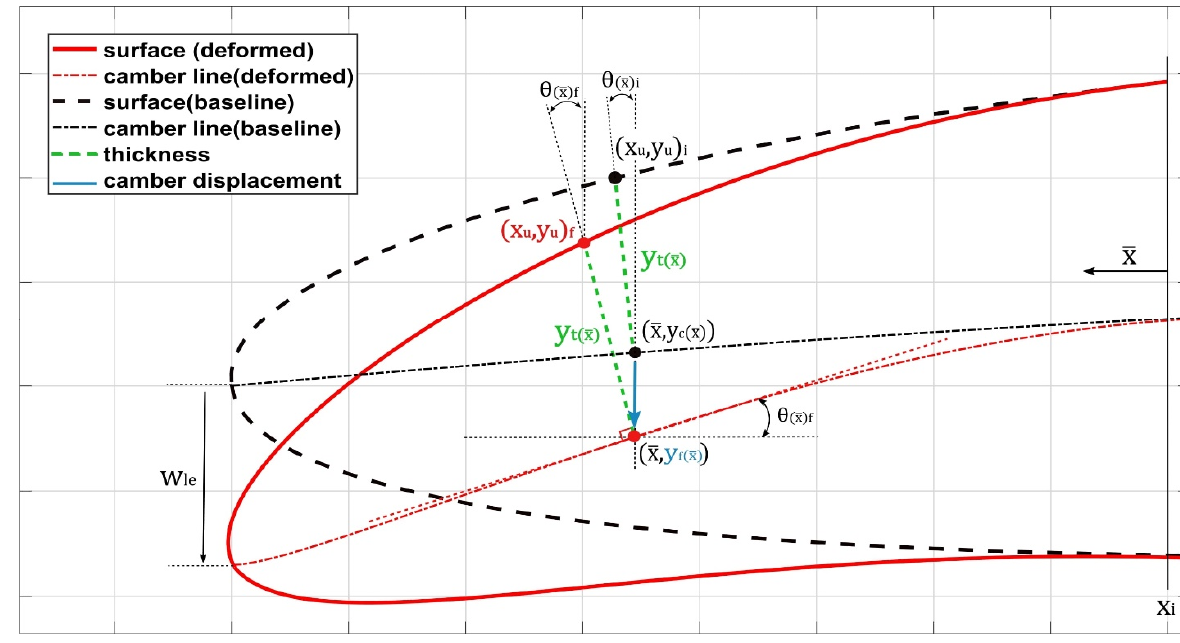
Figure 2. Numerical modeling of a camber line.